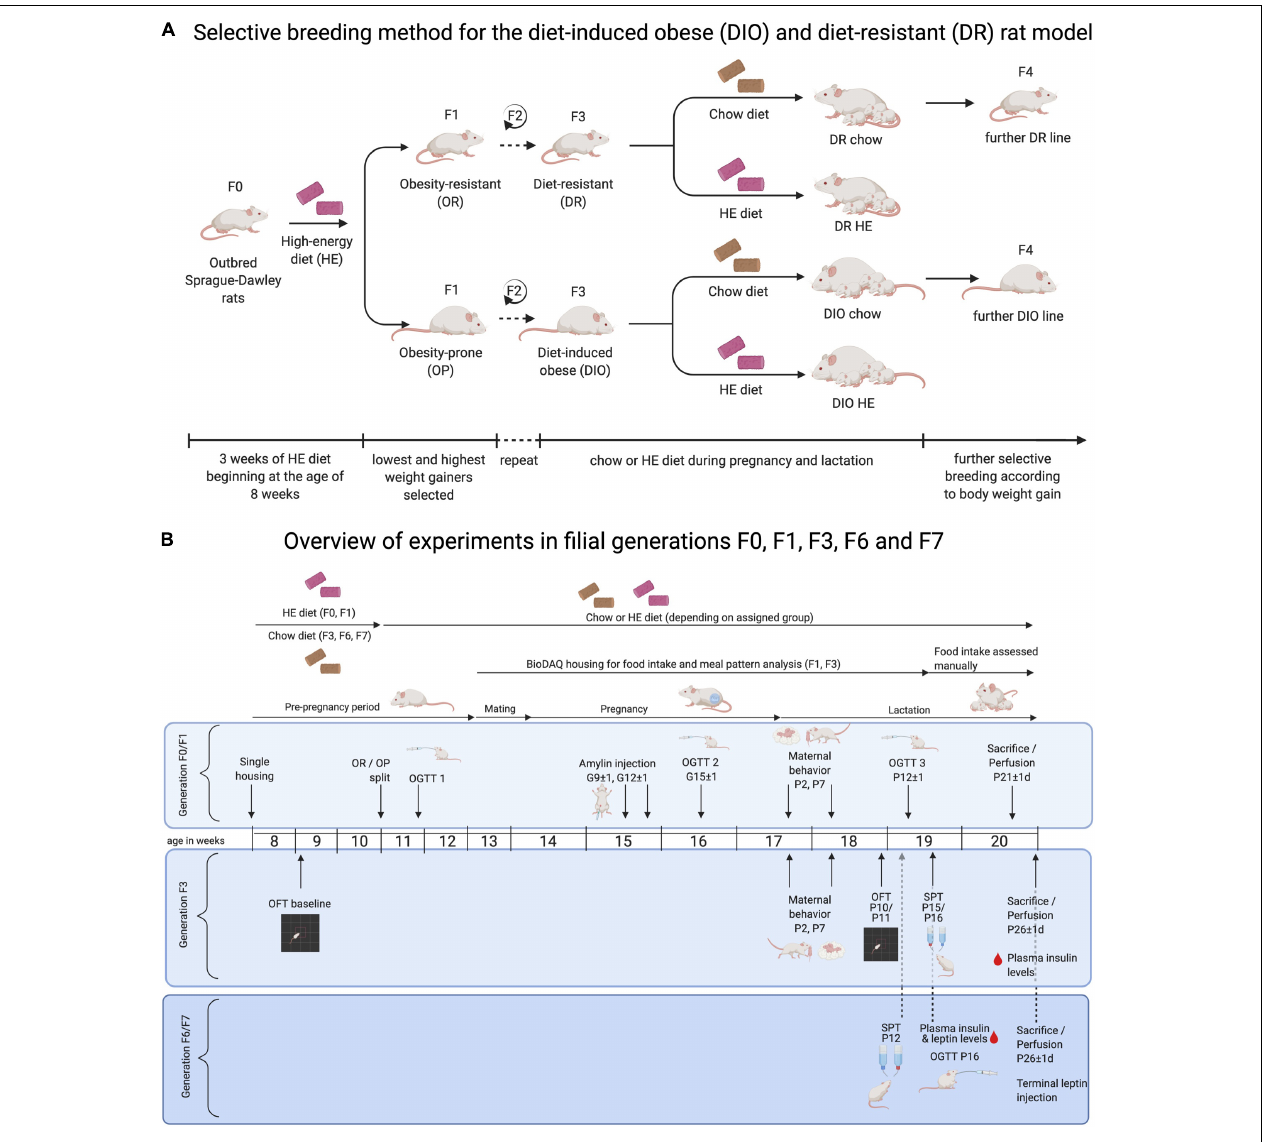
FIGURE 1 | Overview of protocol for selective-breeding of DIO and DR rats and the timelines of experimental procedures in pregnant and lactating rat dams. (A) Outbred Sprague-Dawley rats (F0) were used to generate selectively bred colonies of diet- resistant (DR) and diet-induced obese (DIO) rats, according to protocols developed by Levin and colleagues. Following a 3-week challenge on sweetened high-energy diet (HE), rats were classified as obesity-resistant (OR) or obesity-prone (OP) based on their weight gain. OR and OP male and female rats were mated, and the process was repeated in F1 and F2 offspring. Rats were designated as DR and DIO from F3 forward. For breeding and experimental purposes, F3, F6, and F7 DR and DIO dams were maintained on chow or HE from the time of mating and until the time of pup-weaning. Offspring from chow-fed dams were used for colony maintenance. (B) Three experiments were carried out in dams from F0/F1, F3, and F6/F7 generations, respectively. Maternal body weight and food intake were collected at least weekly over the course of the studies. Experimental procedures were performed on the gestational (G) and postpartum (P) days indicated, including: oral glucose tolerance test (OGTT); amylin sensitivity test; pup retrieval and maternal behavior test; open field test (OFT); and sucrose preference test (SPT). Between P21 and P26, rat dams were perfused, and blood, brains, and livers were harvested for further analysis. Diagrams were created with a paid-subscription of